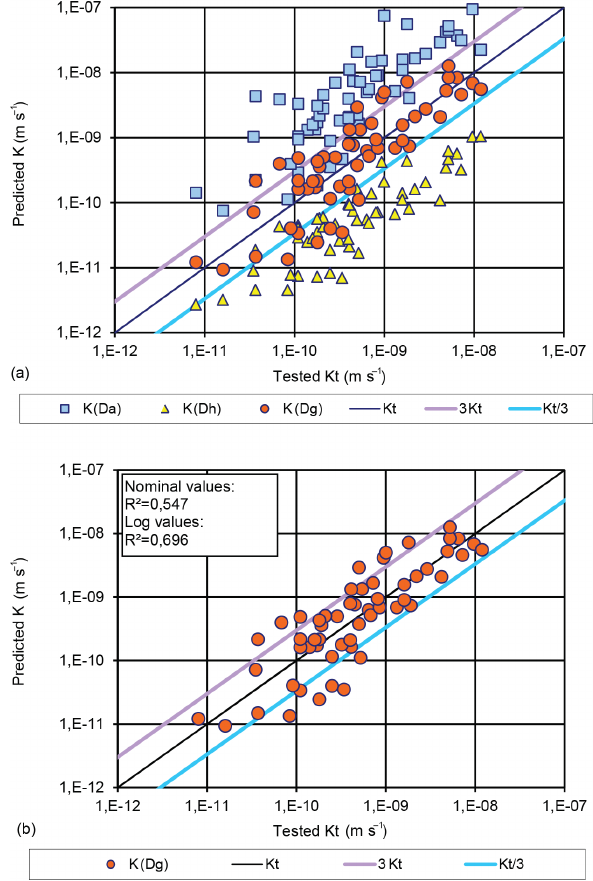
Figure 11. Graphical correlation between predicted K and tested K t for sandy and gravelly aquifers. (a) Difference between arithmetic, geometric and harmonic mean grain size. (b) Results of correlation between predicted K(D g ) and tested K t .